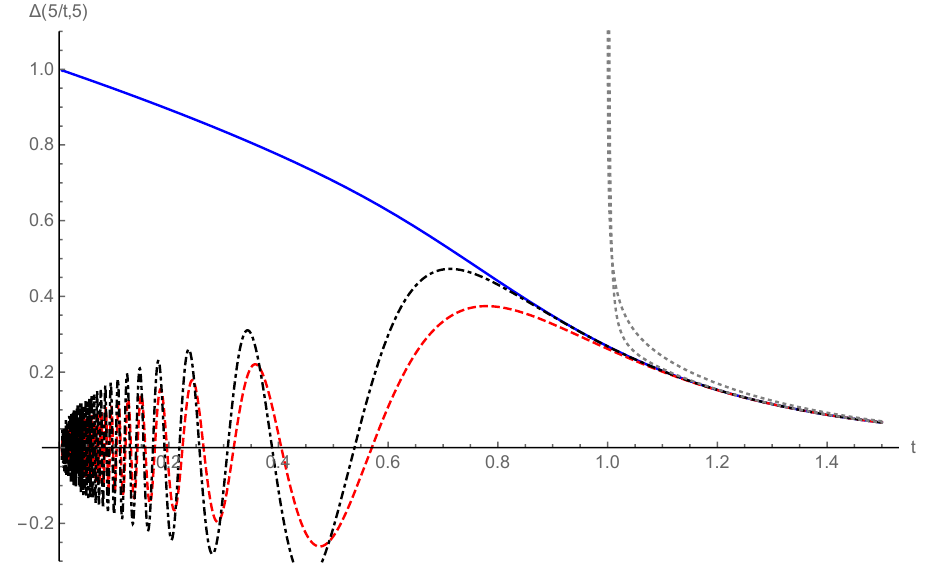
Figure 14 . The t dependence of (cid:1)( t; N ) [blue curve] and the leading strong-coupling large N contribution (cid:1) ( t; N ) = J N ( N=t ) [red dashed curve] in the strong coupling regime at N = 5. (1) The black dot-dashed curve includes the three-instanton contribution (cid:1) ( t; N ) in (5.14). The (3) agreement is excellent, even at the N = 1 GWW transition point t = 1. The dotted grey curves, which diverge at the transition point, show the leading instanton terms in the conventional large N strong-coupling expansion in (5.38), which has e(cid:11)ectively used the Debye expansion for the Bessel functions appearing in (5.8) and